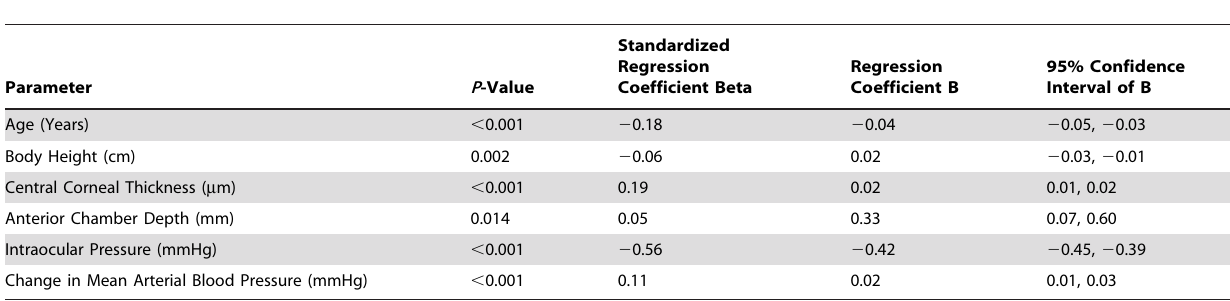
Table 2. Associations between the Change in Intraocular Pressure and Ocular and Systemic Parameters in the Beijing Eye Study 2006/2011 (Multivariate